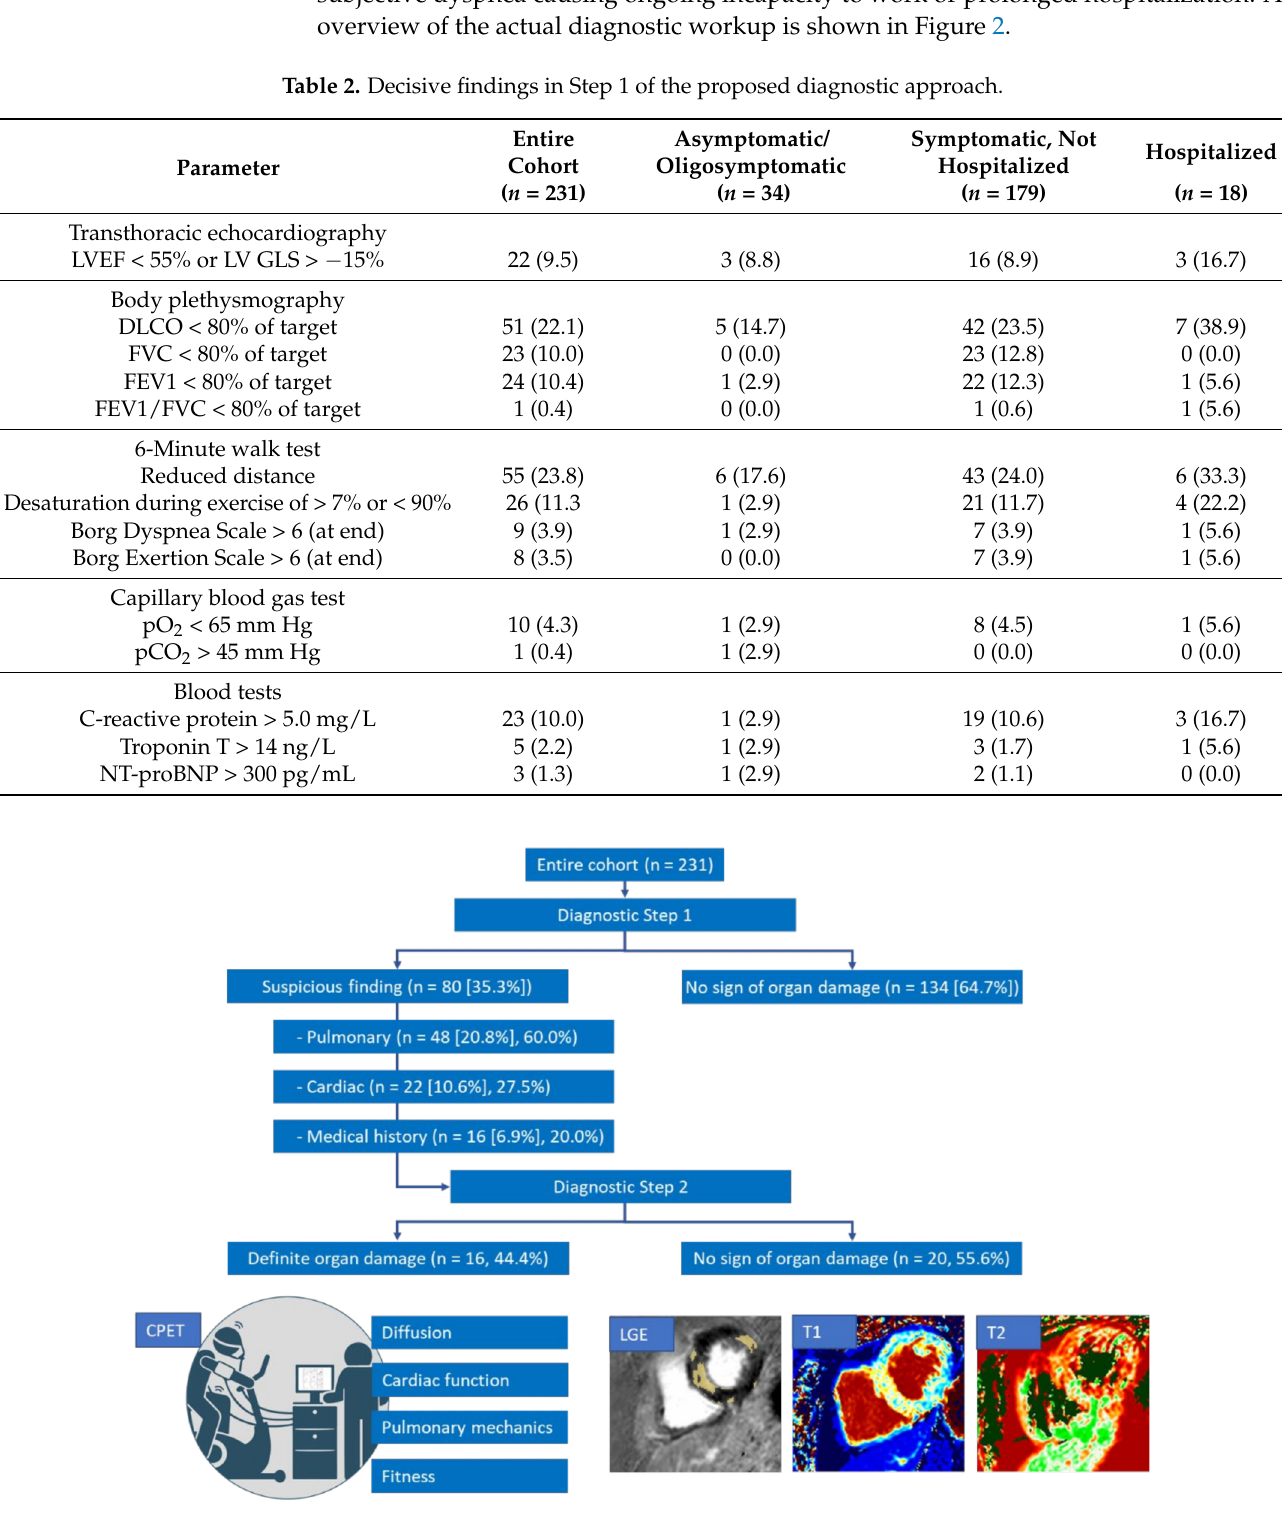
Figure 2. Diagnostic stepwise workup of 231 patients with long COVID. CPET, cardiopulmonary exercise testing; LGE, late gadolinium enhancement. The percentage in square brackets is according to the entire cohort, the other percentage refers to the proportion of patients in the distinct diagnostic